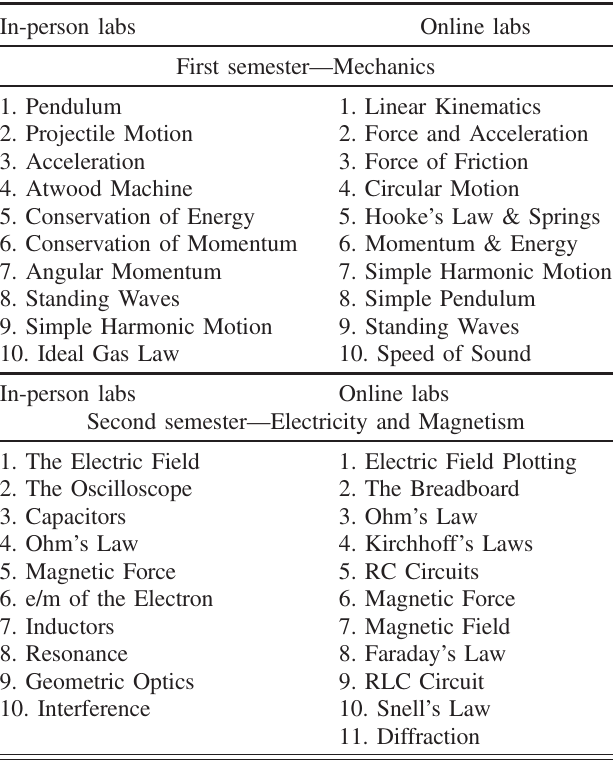
TABLE I. List of labs offered in the first and second semester of